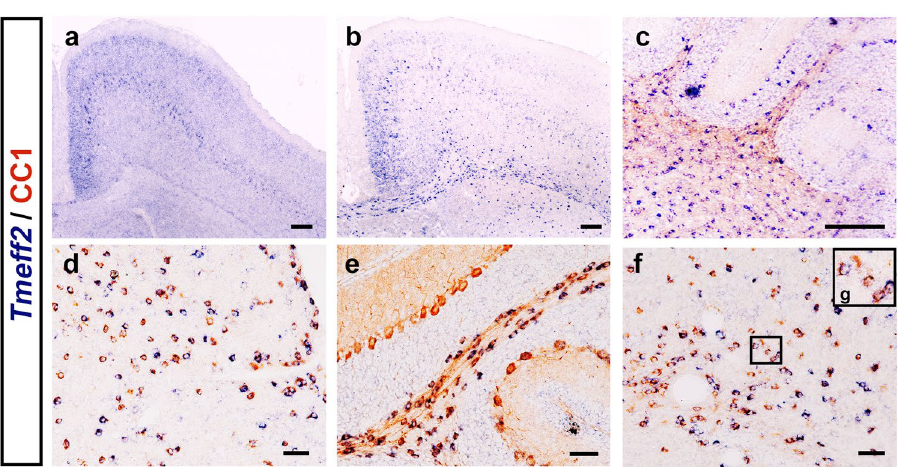
Figure 1. Tmeff2 is up-regulated in differentiating OLs. ( a–f ) Sections of E16.5, E18.5, P3, P7, P15 and P30 mouse spinal cords were subjected to ISH with Tmeff2 riboprobe. Tmeff2 is mainly expressed in gray matter at embryonic stages, but switches its expression to OLs after birth. Bar, 100 μ m.